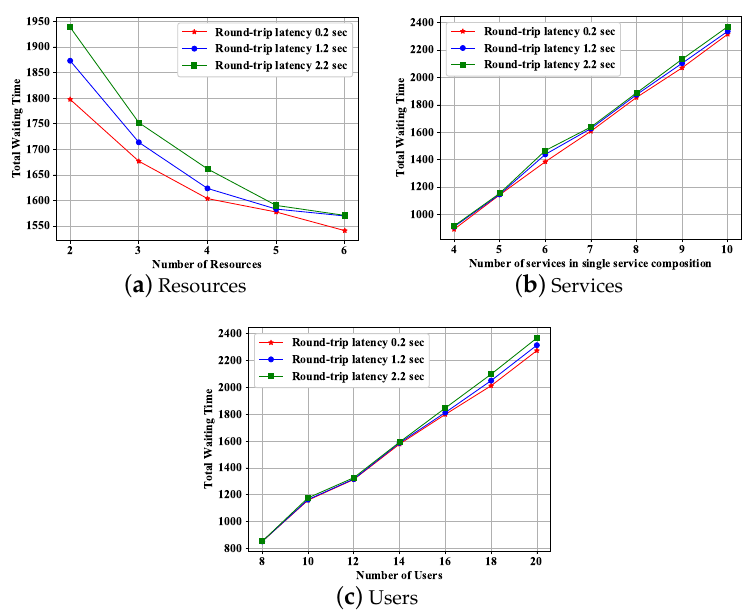
Figure 7. Impact of the round-trip on the total waiting